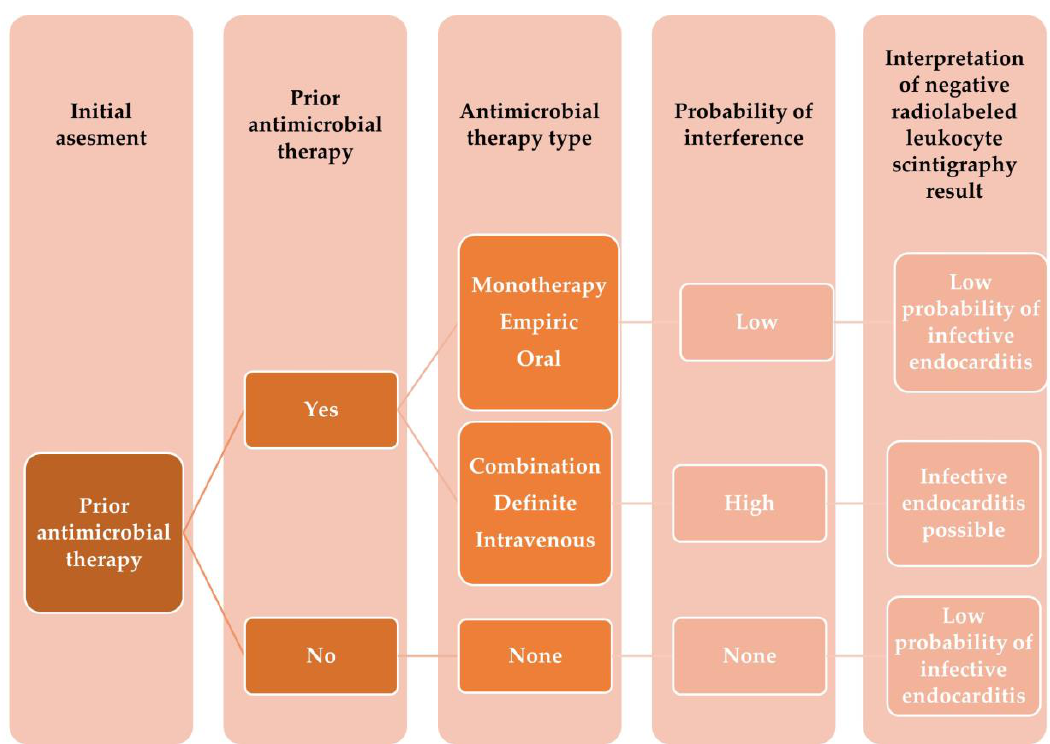
Figure 3. Shows the proposed algorithm on how to interpret a negative 99m Tc-HMPAO-SPECT/CT results in patients with suspected infective endocarditis receiving antimicrobial therapy prior to examination. Adapted from Holcman, K.; et al. To what extent does prior antimicrobial therapy affect the diagnostic performance of radiolabeled leukocyte scintigraphy in infective endocarditis [32]?